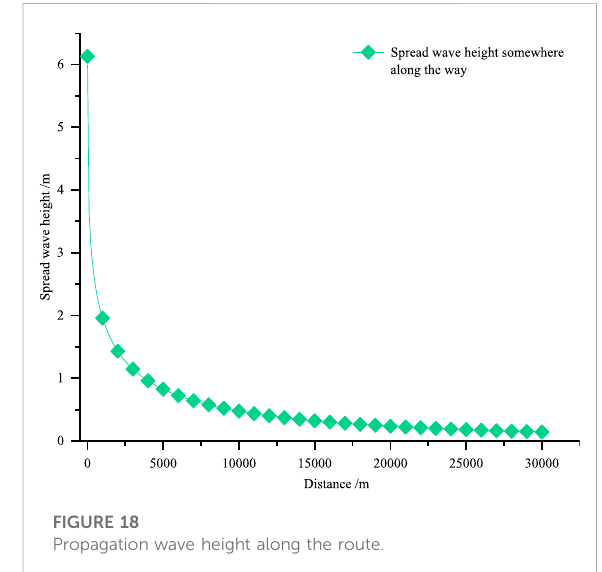
FIGURE 18 Propagation wave height along the